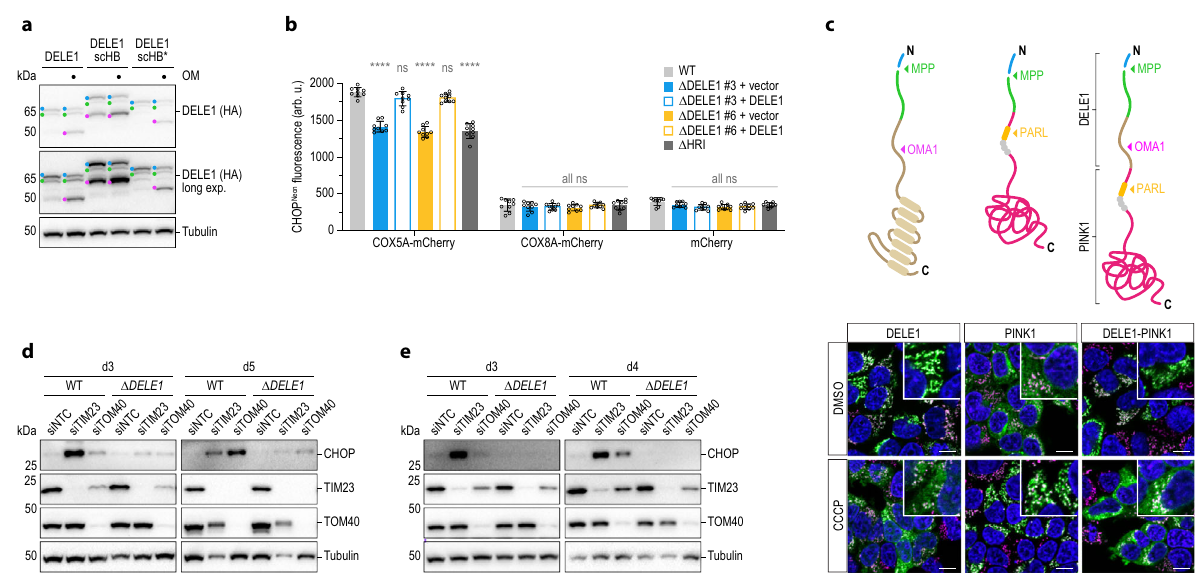
Fig. 6 DELE1 responds to various types of perturbed mitochondrial protein import. a 293T cells were transiently transfected with the speci fi ed constructs and DELE1 processing upon 4 h OM treatment was analyzed by immunoblotting; scHB, Saccharomyces cerevisiae heme-binding domain. scHB*, destabilized HB domain. b CHOP Neon fl uorescence in the indicated cell lines was analyzed 20 h after transfection of mCherry fused to the sorting signals of COX5A or COX8A. Graph depicts mean ± s.d. of n = 3 independent experiments each containing three biological replicates. Statistical signi fi cance compared to WT within each construct is shown and was assessed using two-way ANOVA with Tukey ’ s multiple comparisons correction. COX5A- mCherry: **** P < 0.0001, ns ≥ 0.1712; COX8A-mCherry: ns ≥ 0.9994; mCherry: ns ≥ 0.3946. c 293T cells stably expressing the indicated DELE1-PINK1 chimeras were treated with DMSO or CCCP for 4 h and localization of the indicated HA-tagged proteins was analyzed by confocal microscopy. Scale bars, 10 μ m. Nuclei (DAPI, blue), mitochondria (TRAP1, pink), HA (green). d , e CHOP induction upon knockdown of TIM23 or TOM40 by siRNA transfection into HeLa ( d ) or 293T ( e ) WT or DELE1 knockout ( Δ DELE1 ) cells was analyzed by immunoblotting at the indicated times a chimeric PINK1 protein by transplantation of the DELE1 N-terminus. In contrast to DELE1, wild-type PINK1 was detected